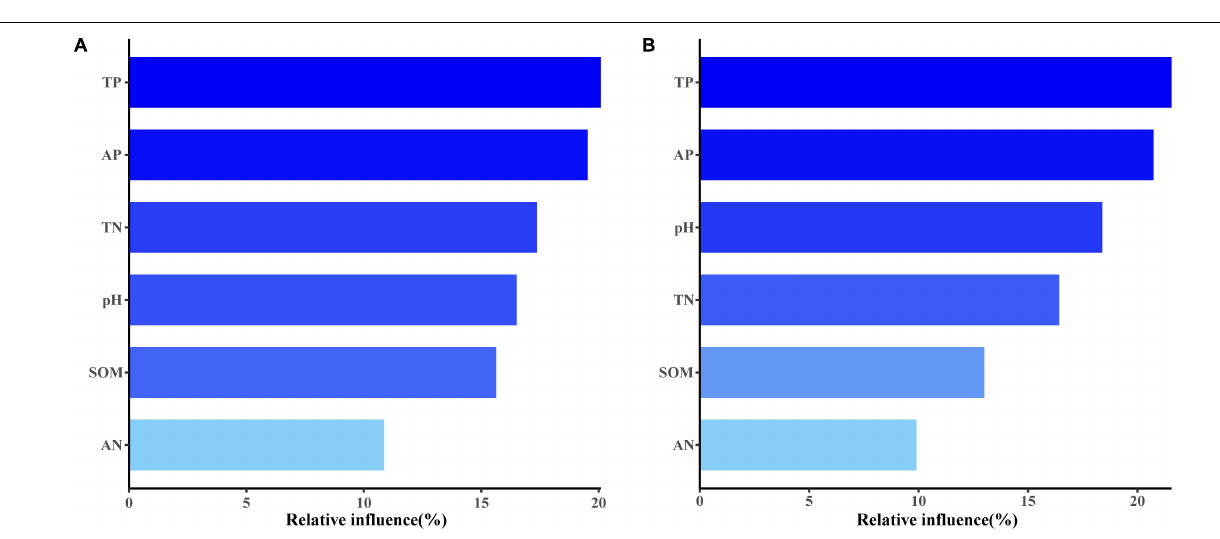
FIGURE 8 | The aggregated boosted tree (ABT) analysis showed the relative influence of each soil factor on AM fungal community composition on conventional (A) and organic (B) maize